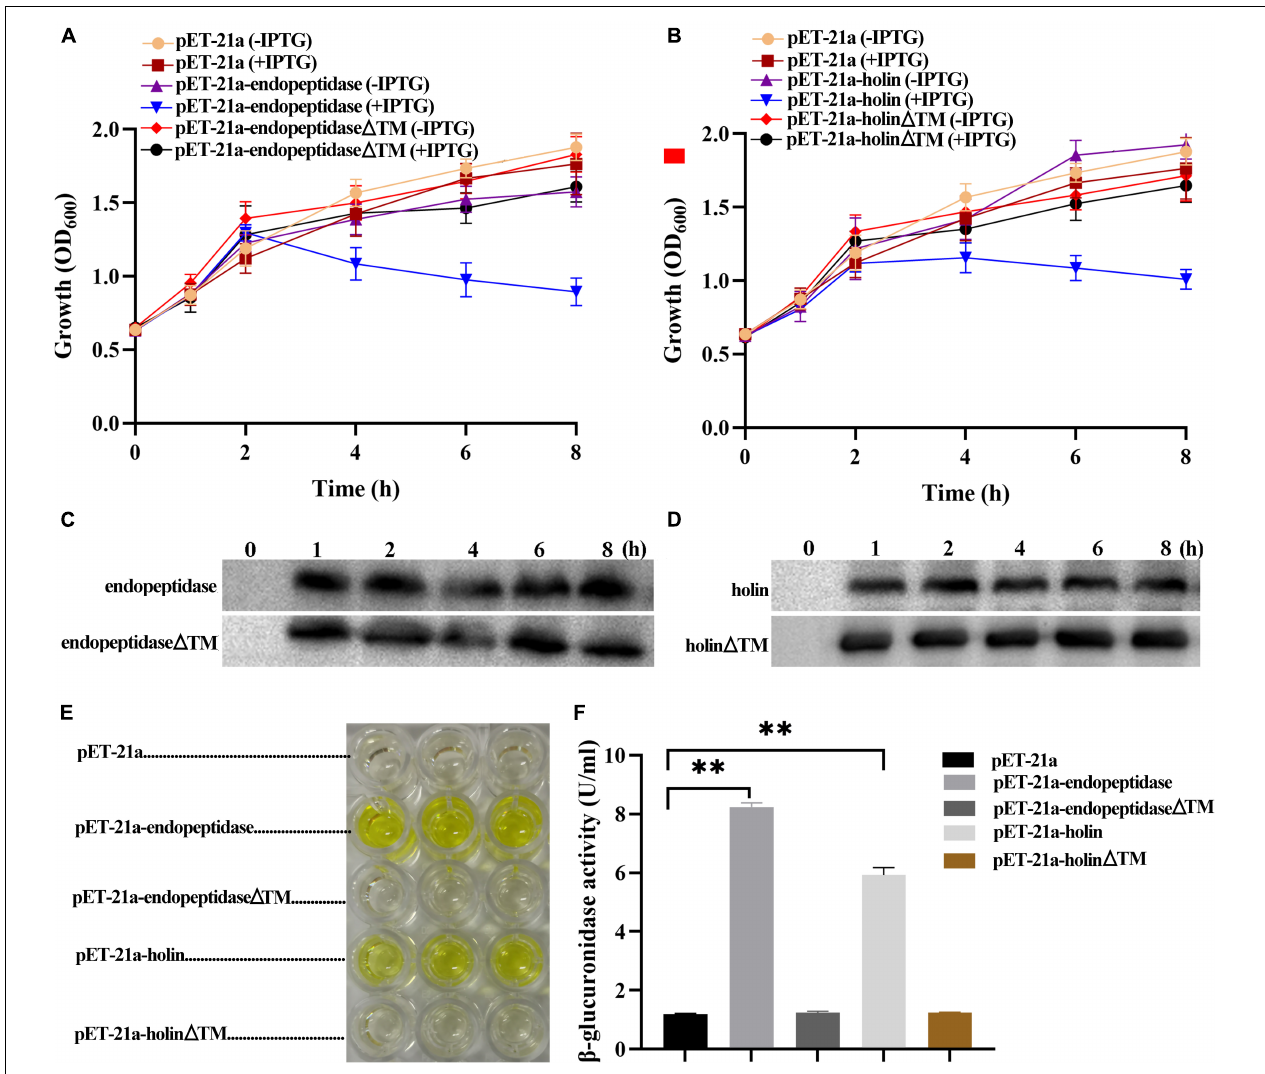
FIGURE 2 | Effect of endopeptidase and holin on the growth activity of E. coli . (A) The growth curves of induced and uninduced strains (DE3: pET-21a, DE3: pET-21a- endopeptidase, and DE3: pET-21a-endopeptidase (cid:49) TM). (B) The growth curves of induced and uninduced strains (DE3: pET-21a, pET-21a-holin, and DE3: pET-21a- holin (cid:49) TM). (C) Western blotting was performed with total cellular proteins from IPTG-induced DE3: pET-21a-endopeptidase and DE3: pET-21a-endopeptidase (cid:49) TM. (D) Western blotting was performed with total cellular proteins from IPTG-induced DE3: pET-21a-holin and DE3: pET-21a-holin (cid:49) TM. (E) The color of the solution changed after adding galactosidase substrate (ONPG) to the supernatant of different strains (DE3: pET-21a, DE3: pET-21a-endopeptidase, DE3: pET-21a-endopeptidase (cid:49) TM, DE3: pET-21a-holin, and DE3: pET-21a-holin (cid:49) TM). (F) The β -galactosidase activity was determined for extracellular supernatant from induced strains. The data were shown as means ± standard deviation from three independent experiments. The “ ∗∗ ” indicates statistical significance ( T -test, p < 0.01).